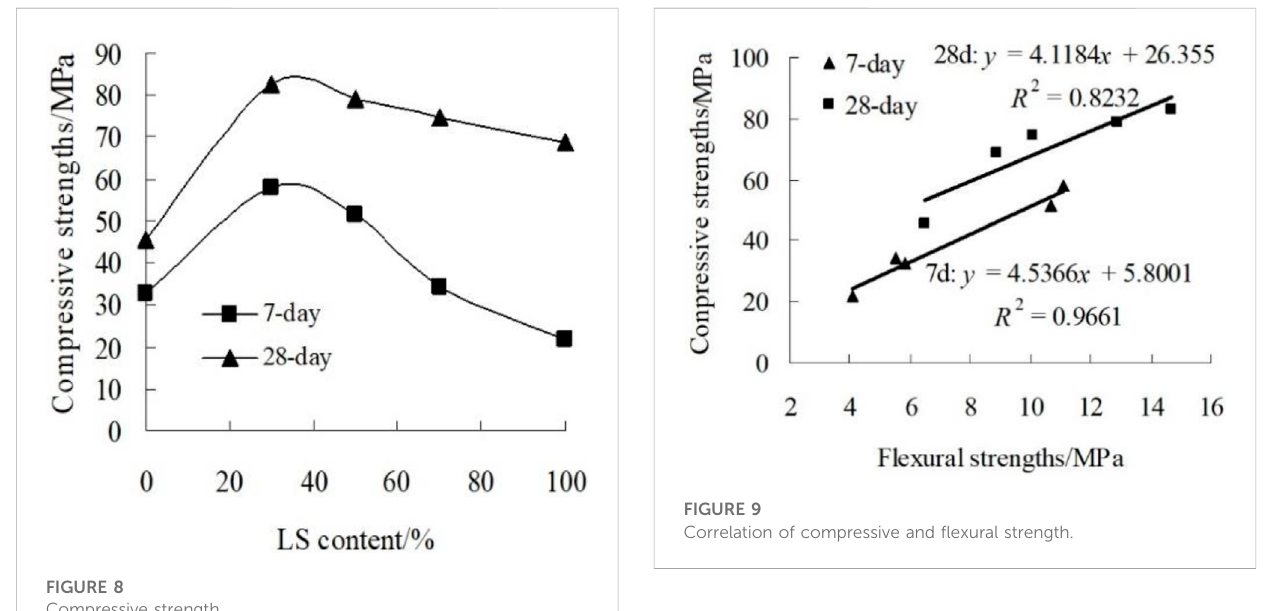
FIGURE 8 Compressive strength.